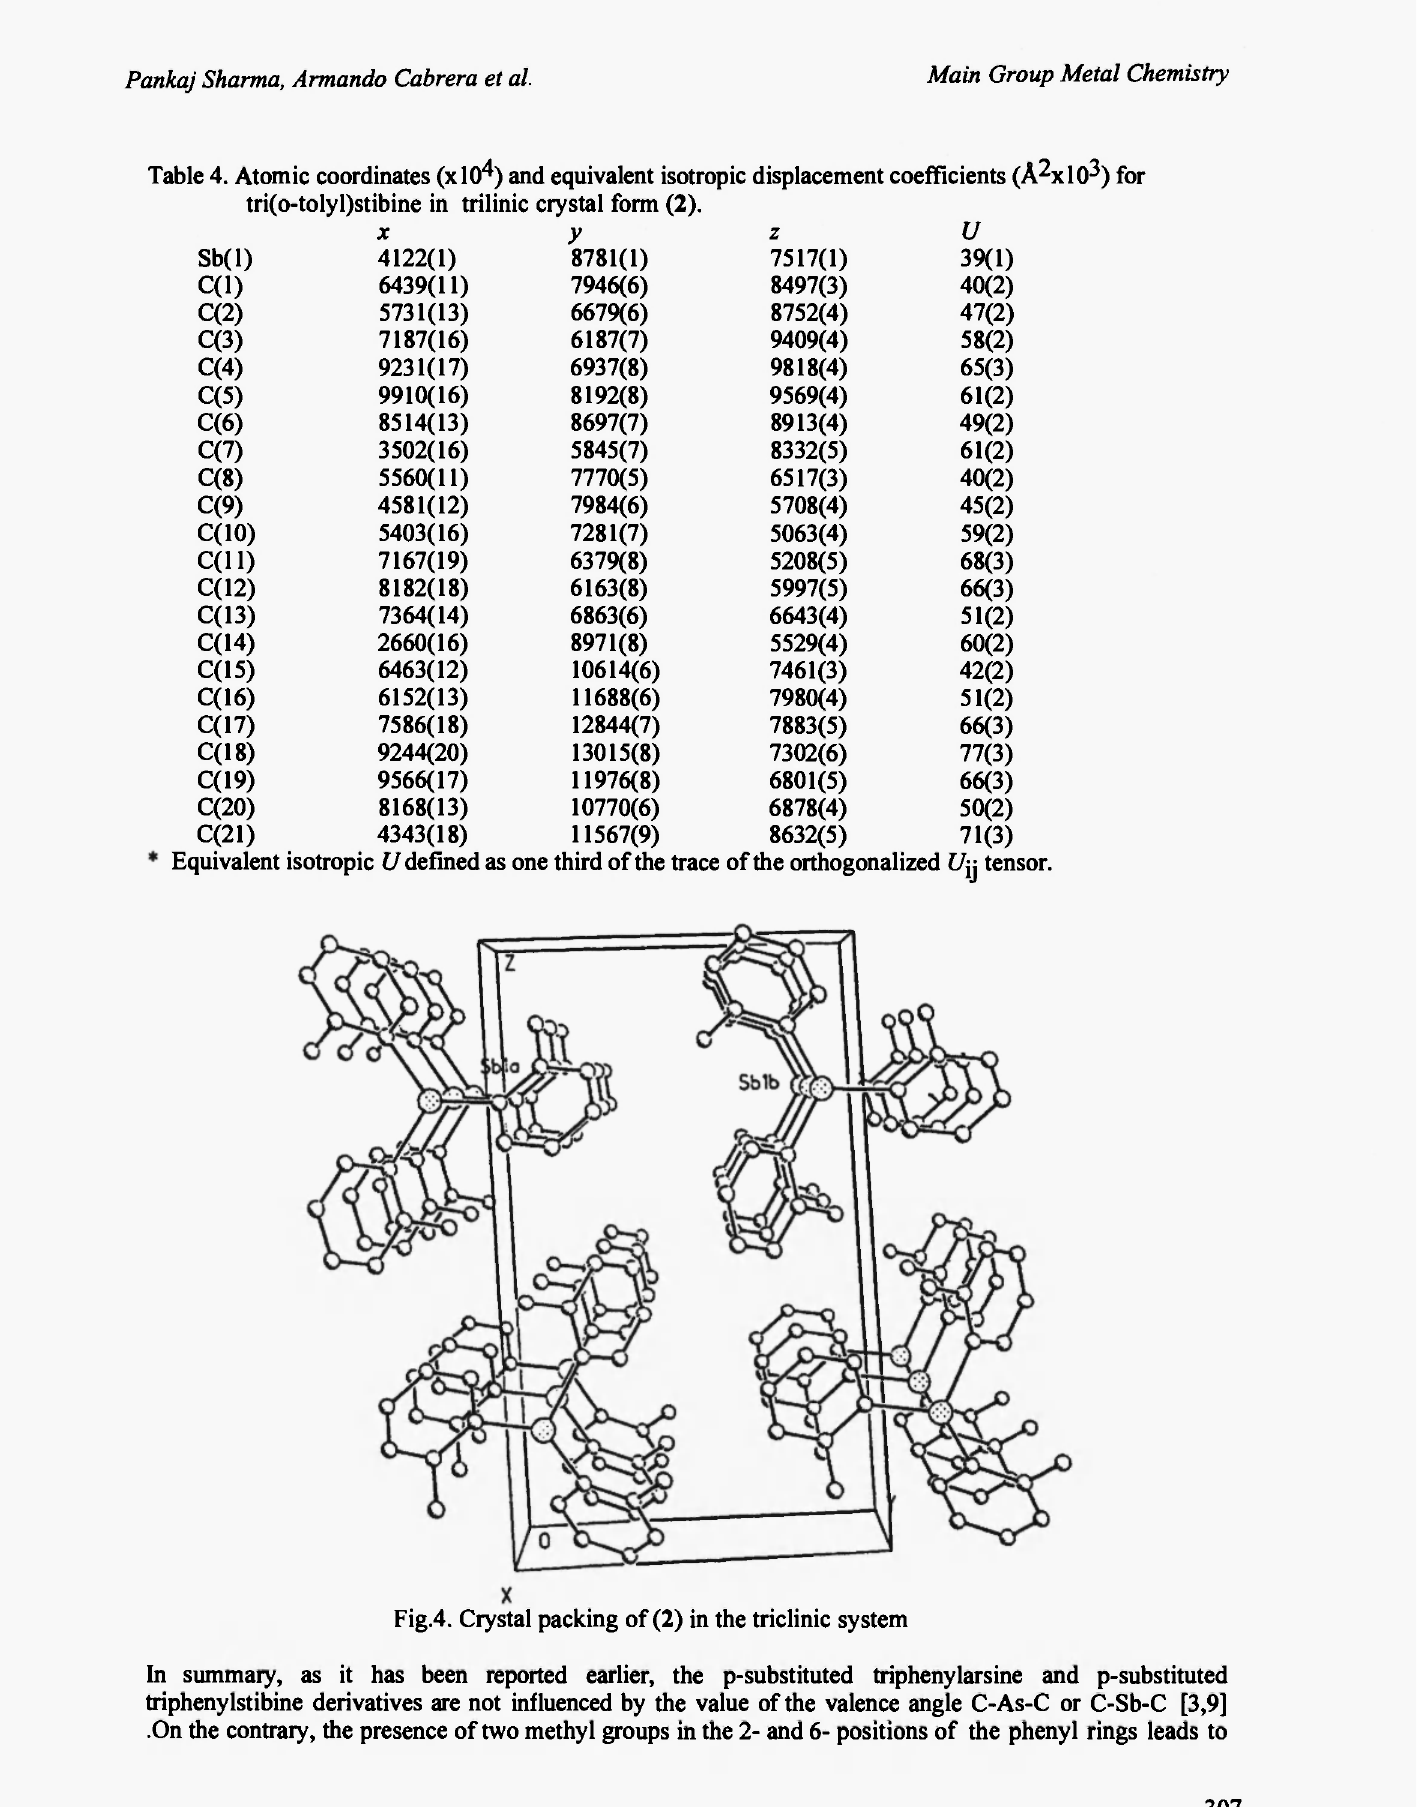
Table 4. Atomic coordinates (xlO^) and equivalent isotropic displacement coefficients (A^xlO^) for tri(o-tolyl)stibine in trilinic crystal form (2).